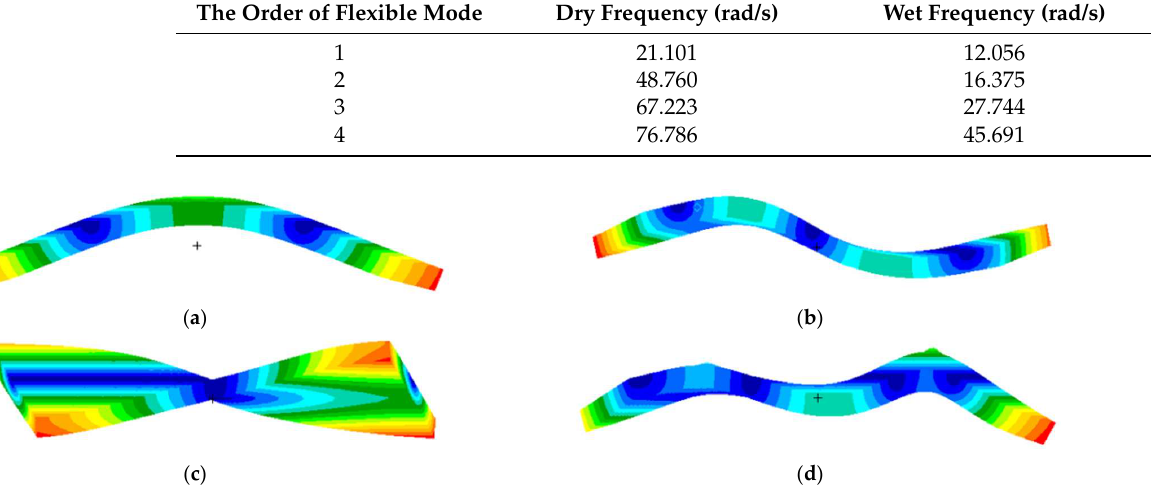
Figure 5. The schematic diagram of modal of a trapezoidal floating model. ( a ) The first order flexi- ble mode. ( b ) The second order flexible mode. ( c ) The third order flexible mode. ( d ) The fourth order flexible